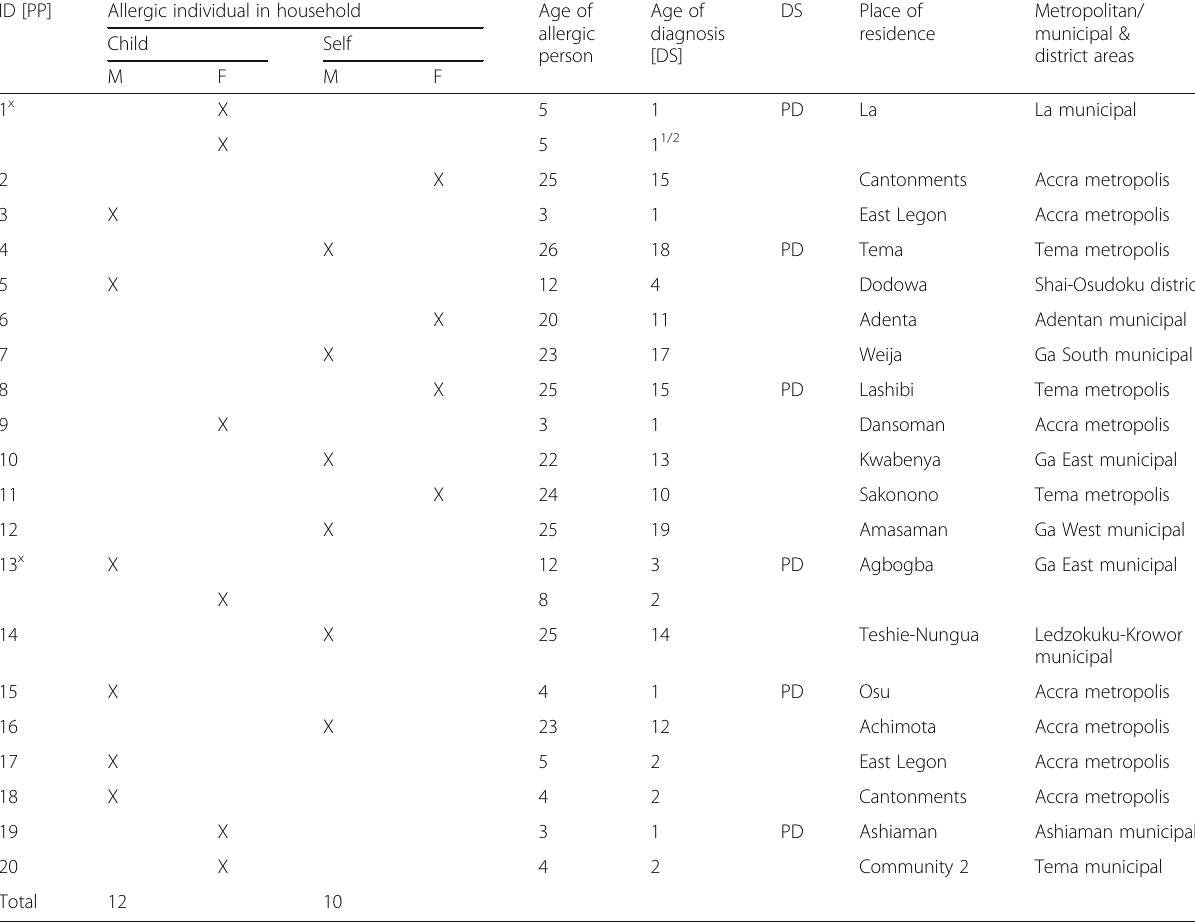
Table 2 Characteristics of allergic population [ n = 22] a